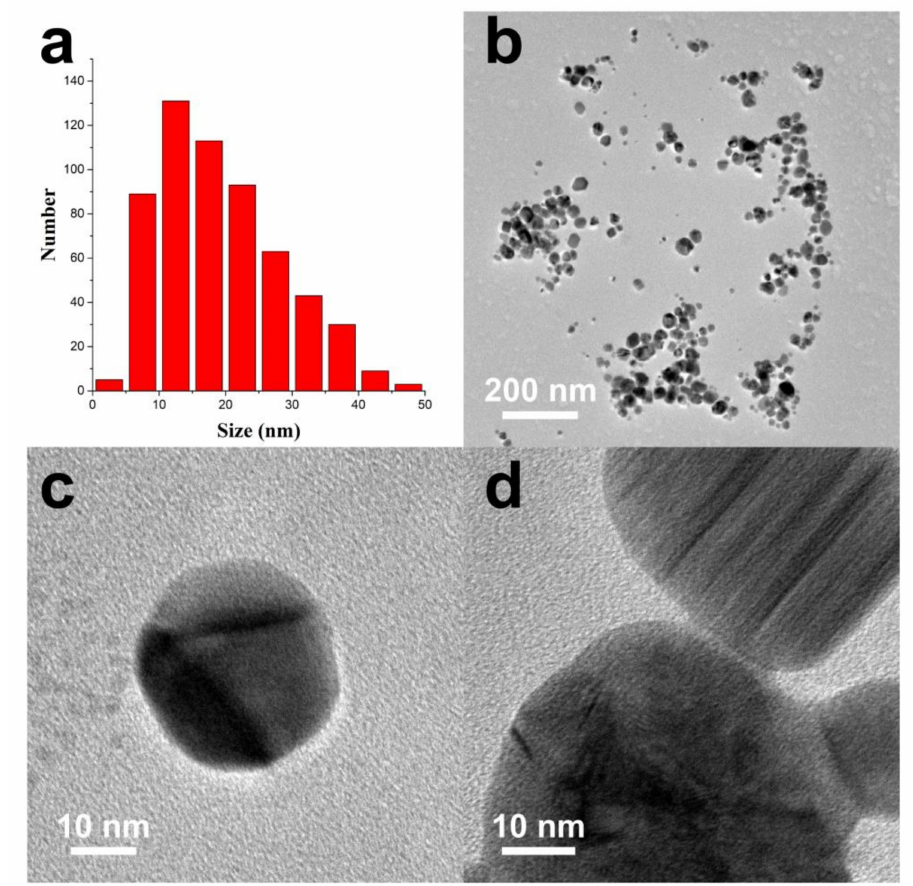
Figure 3. ( a ) particle size distribution of CMC-SNs; ( b – d ) TEM (transmission electron microscope) images of